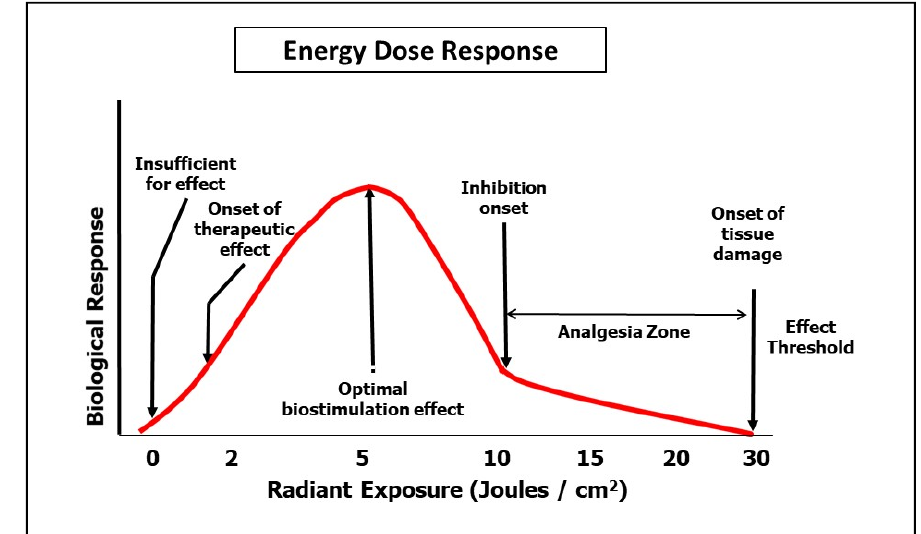
Figure 4. Multiphasic dose response.